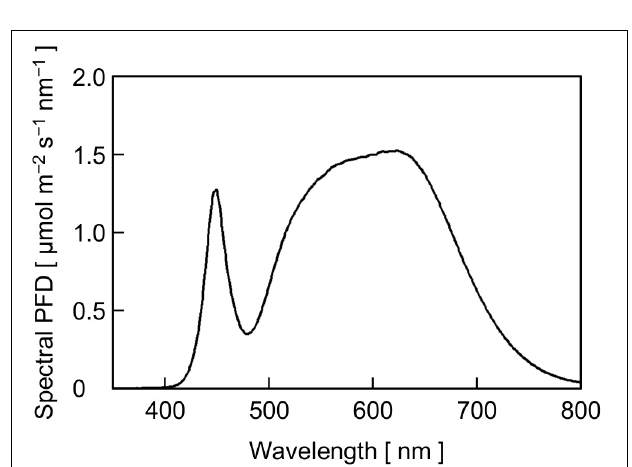
FIGURE 2 | The SPD of phosphor-converted white LED light for cucumber seedling growth at a PPFD of 300 µ mol m − 2 s − 1 .